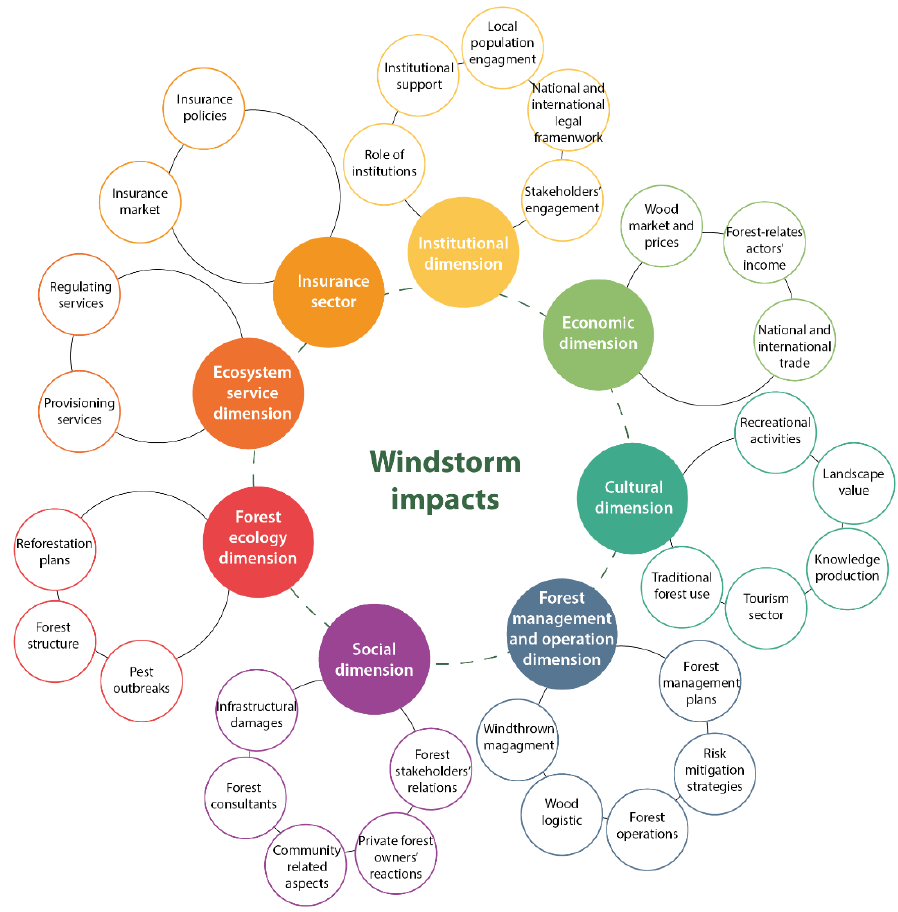
Figure 1. Dimensions and macro-categories considered in the analysis. Dimensions are reported in full-colored circles, while sub-dimensions are reported in smaller and plain circles (Source: own elaboration).